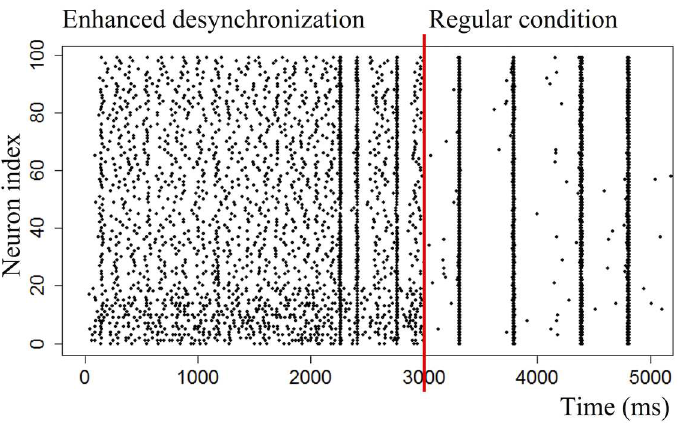
Fig 5. Rasterplots of a regular network (activity concentrated in bursts) and a network of which parameters have been tuned to reduce bursting and enhance desynchronized spiking. The desynchronizingeffect of sparsely connectingthe network and increasing the noise are clearly